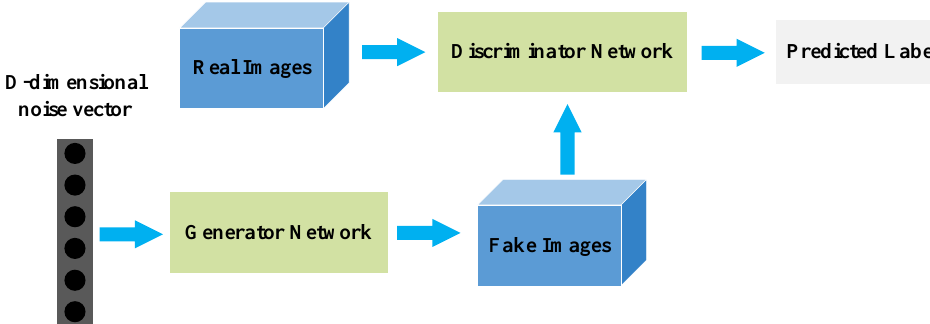
Figure 5. The process of generating an adversary network.